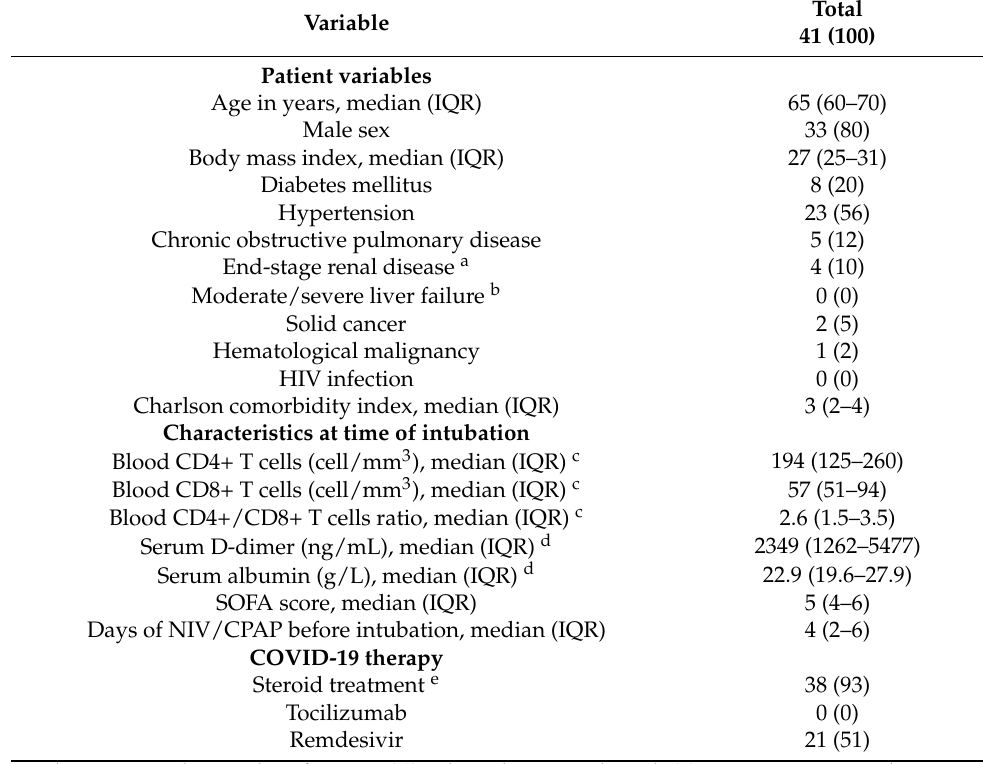
Table 1. Characteristics of the study